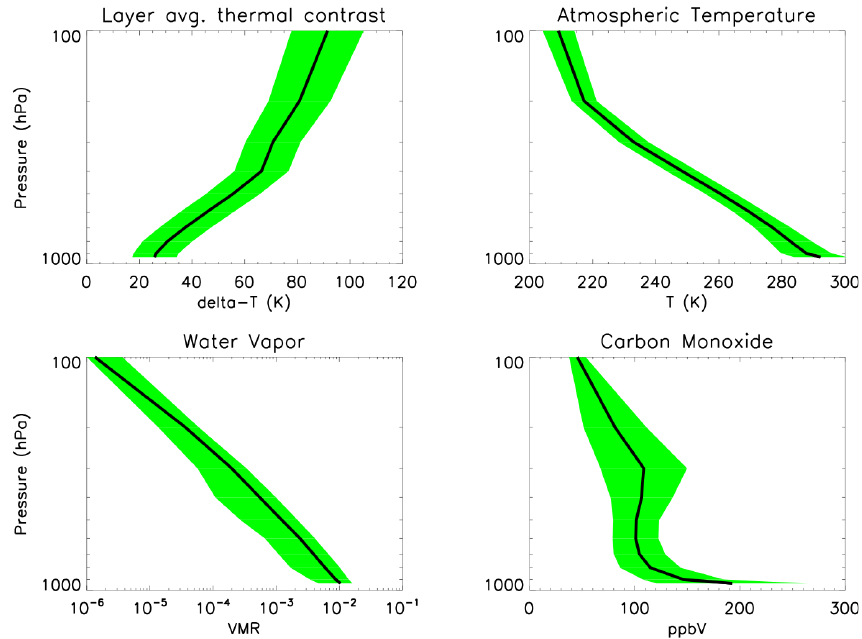
Figure 7. Pressure dependent state parameters for MOPITT CONUS 2006 training set. Black Fig. 7. Pressure-dependent state parameters for MOPITT CONUS 2006 training set. Black lines indicate mean values. Green areas show lines indicate mean values. Green areas show mean ± standard deviation. mean ± standard deviation.